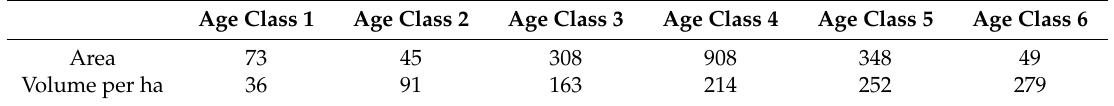
Table 1. Areas and volume of coniferous forest in Korea: by age